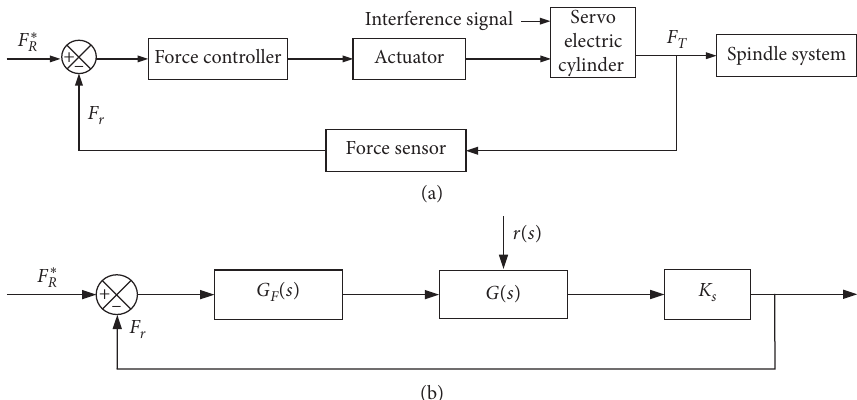
Figure 6: Force closed-loop control model: (a) force closed-loop control structure; (b) corresponding mathematical model.